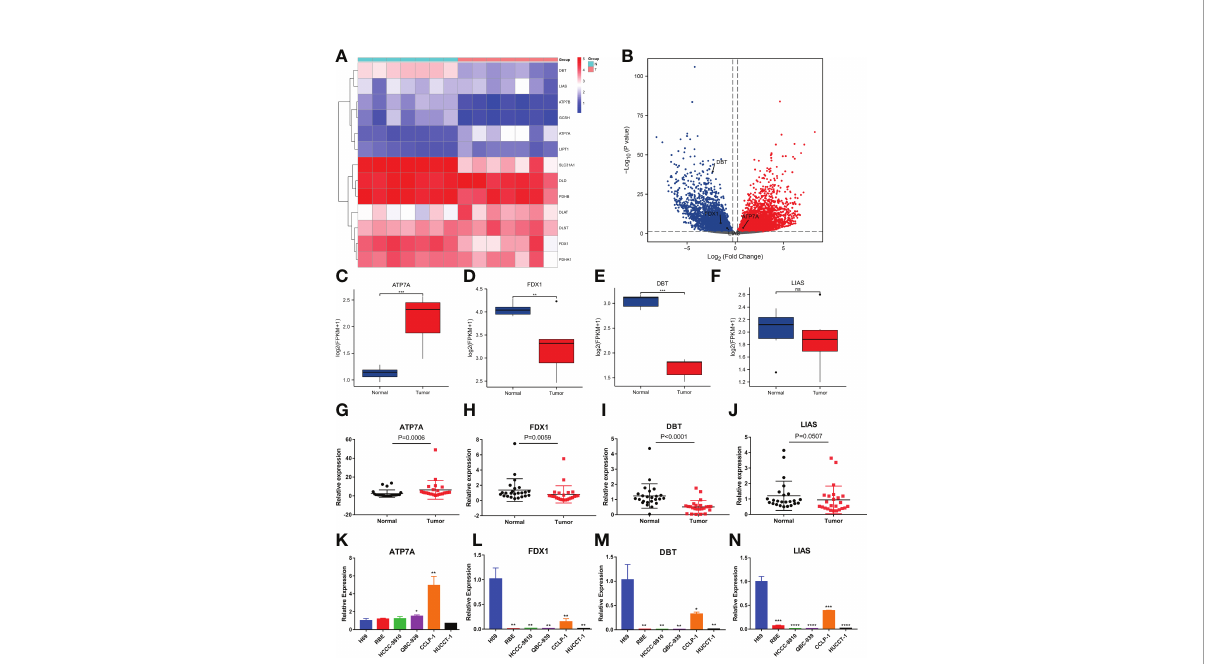
FIGURE 7 Evaluation of the expression of 4 CRGs in tissue samples and different cell types by RNA-seq and qRT − PCR. (A, B) Heatmap and volcano plot demonstrating CRG expression in 7 pairs of samples via RNA-seq. (C – F) Boxplots showing the expression of 4 CRGs in the sequencing results (FPKM: fragments per kilobase million). (G – J) qRT − PCR analysis of ATP7A, FDX1, DBT and LIAS mRNA levels in tissue samples. (K – N) Expression levels of 4 CRGs in the normal bile duct epithelial cells H69 and 5 types of CCA cells (RBE, HCCC-9810, QBC-939, CCLP-1 and HUCCT-1)